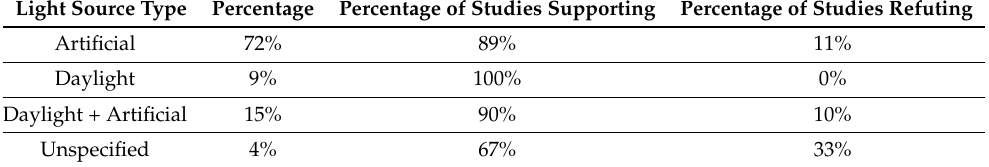
Table 4. Influence of the type of light